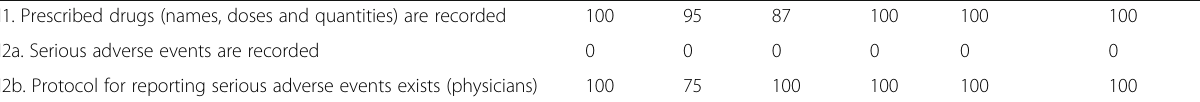
Table 3 Outcomes of implementation of quality indicators by centre (% of positive answers) (Continued) I1. Prescribed drugs (names, doses and quantities) are